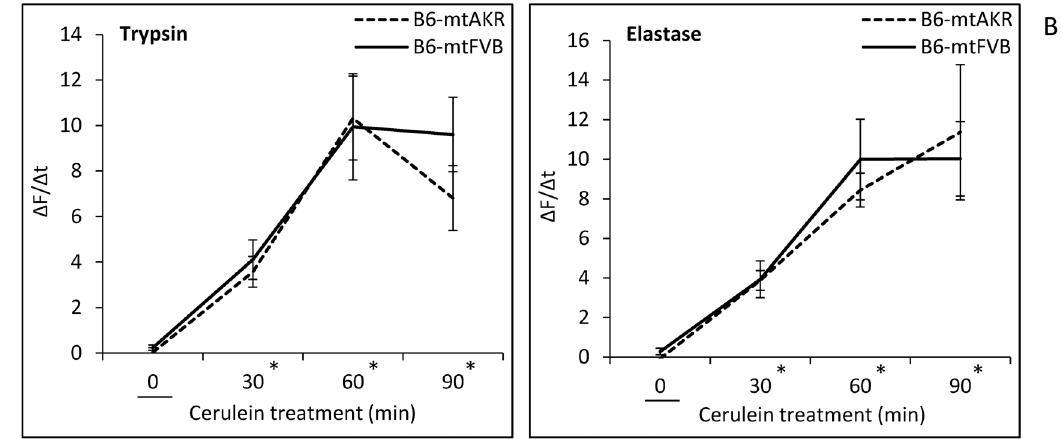
Figure 9. Trypsin and elastase activities in pancreatic acini isolated from B6-mtAKR and B6-mtFVB mice. Isolated pancreatic acini of 12- month-old mice of the two strains were treated in vitro with cerulein (10 nmol/L) for up to 90 min. Subsequently, cleavage of rhodamine 110-labeled synthetic substrates for (A) trypsin and (B) elastase was recorded by cytofluorometry. To compare proteolytic activities, D F/ D t ratios were calculated and data expressed as ( D F/ D t) cerulein -( D F/ D t) untreated (mean 6 SEM, n=6 per experimental group). * P Simple Contrast # 0.001 vs. 0 min